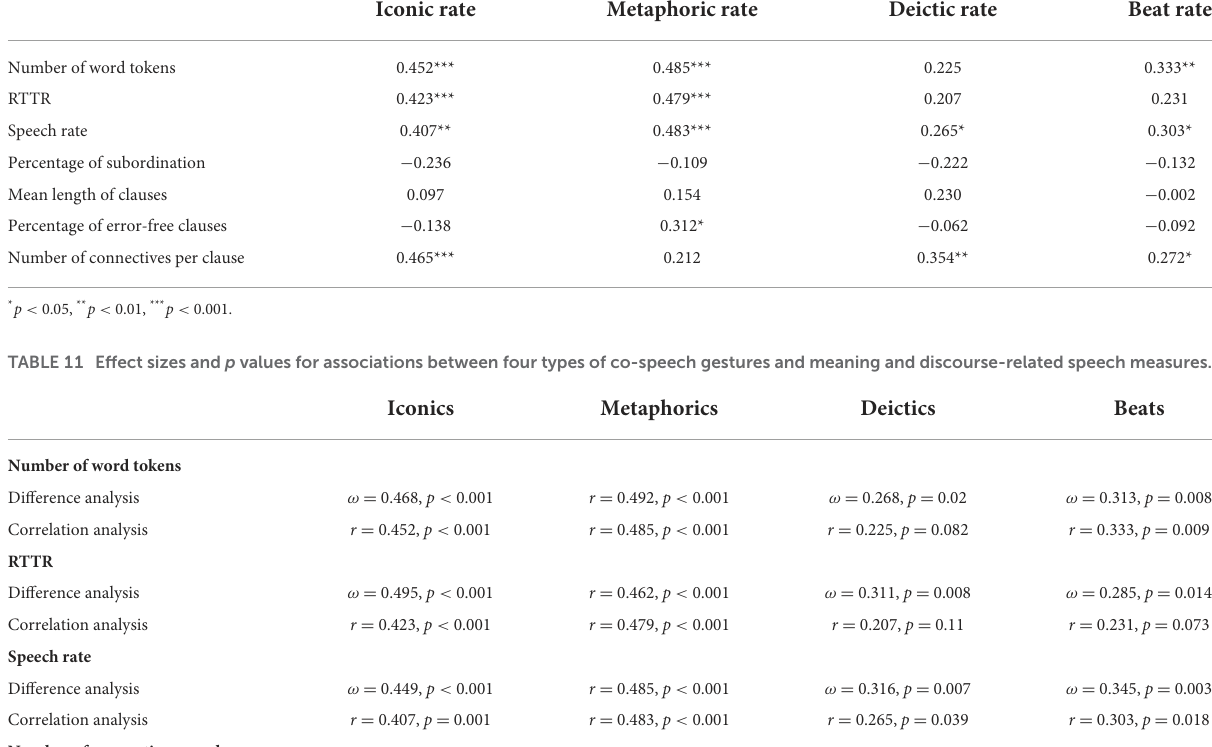
TABLE 10 Correlations (Spearman’s rho) between four types of co-speech gesture rate and speech measures. Iconic rate Metaphoric rate